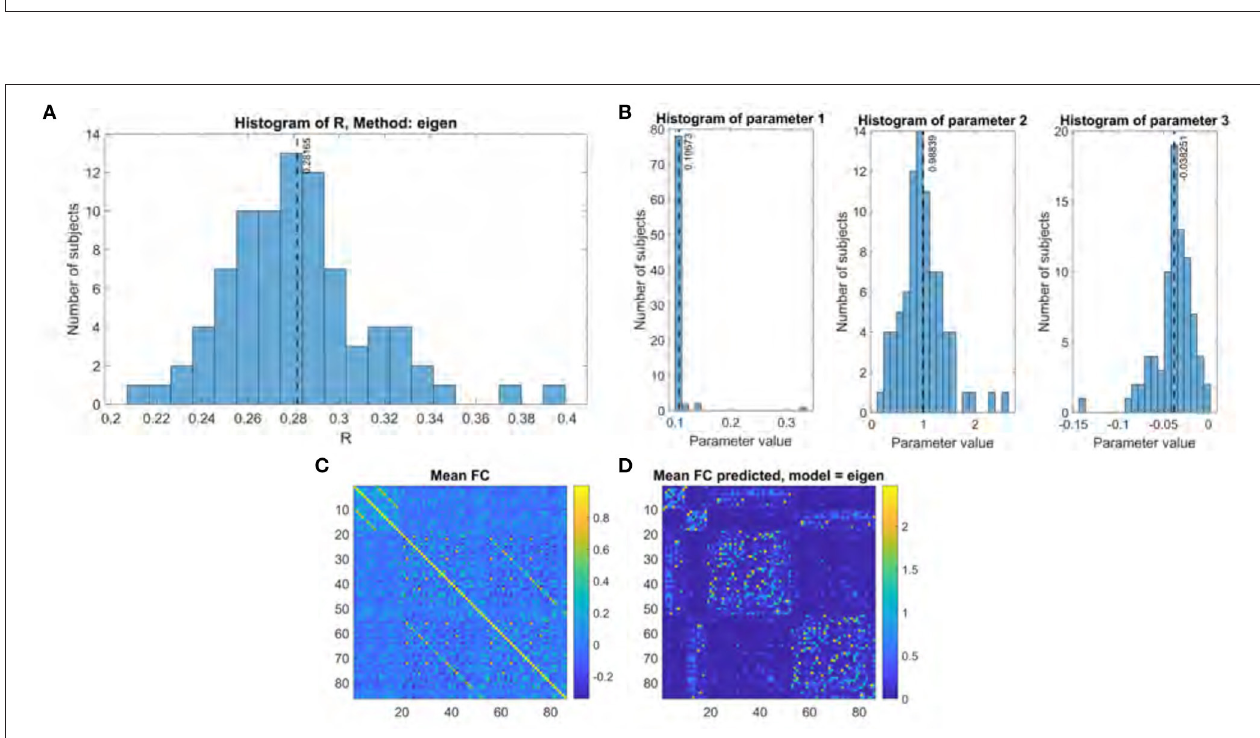
FIGURE 3 | Eigen model performance. (A) Histogram of R score. (B) Histogram of fitted parameters. (C) Mean functional connectome over all subjects. (D) Mean functional connectome predicted by model.